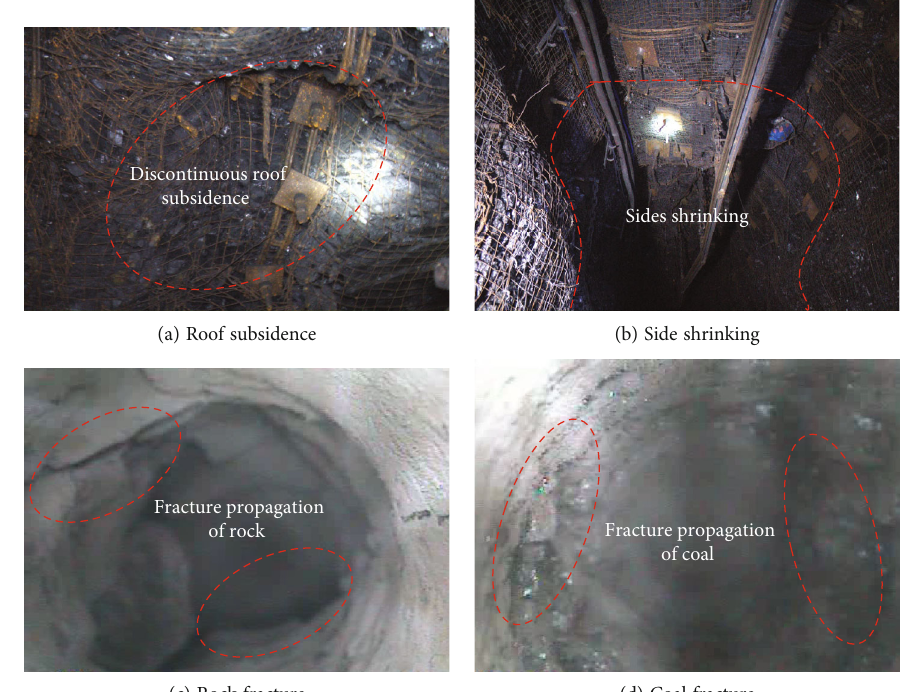
Figure 2: Failure mode of soft